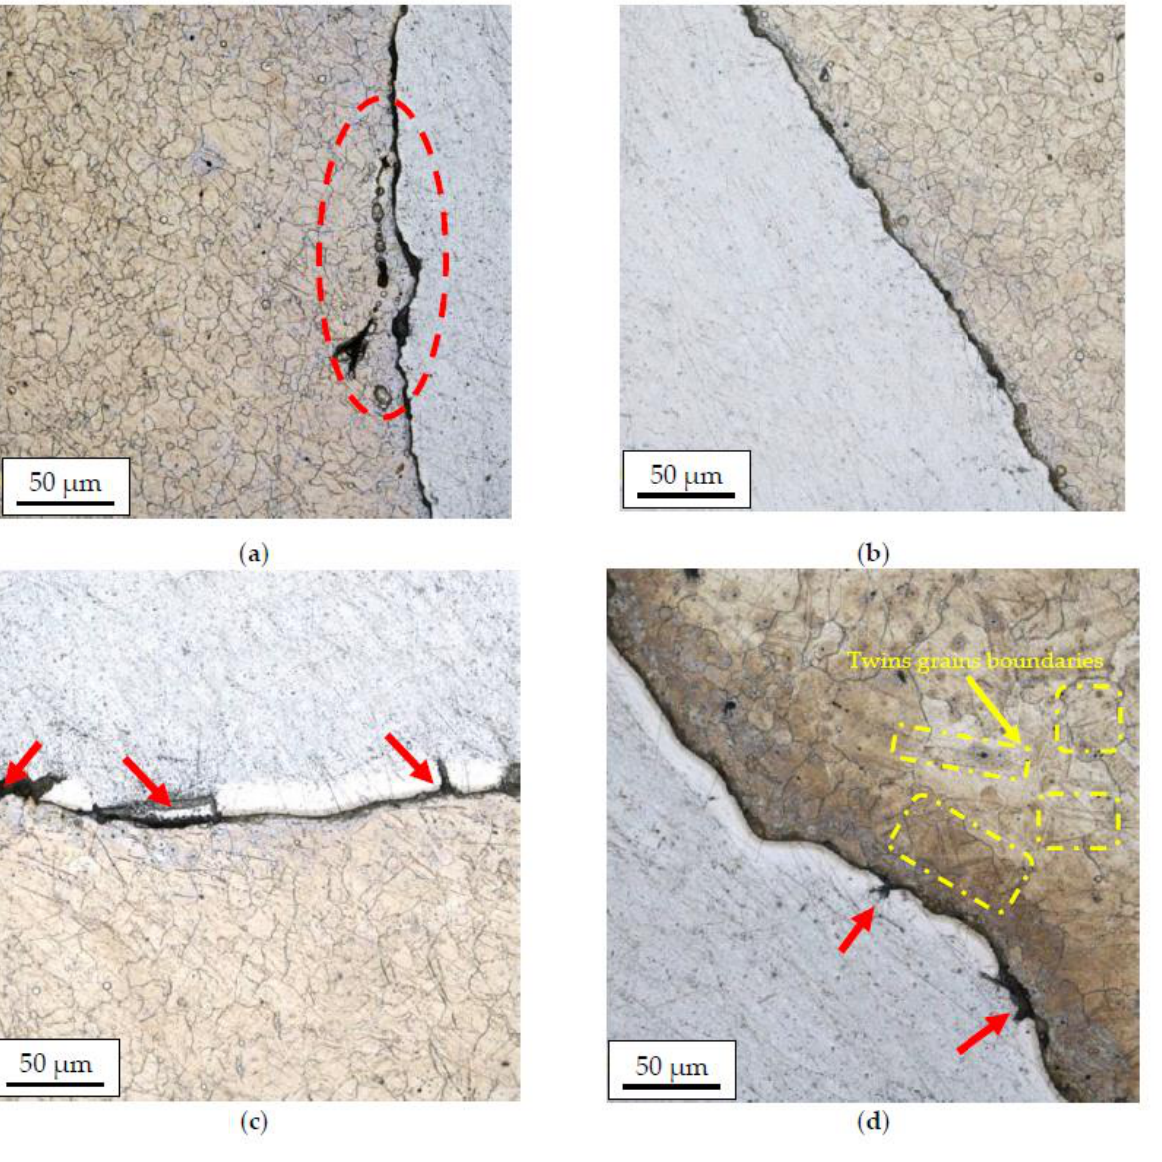
Figure 8. The AZ31 alloy microstructure after rolling in classic passes (variant I), temperature of 300 °C ( a ); modified passes (variant II), temperature of 300 °C ( b ); classic passes (variant I), temperature of 400 °C ( c ); modified passes (variant II), temperature of 400 °C ( d ).